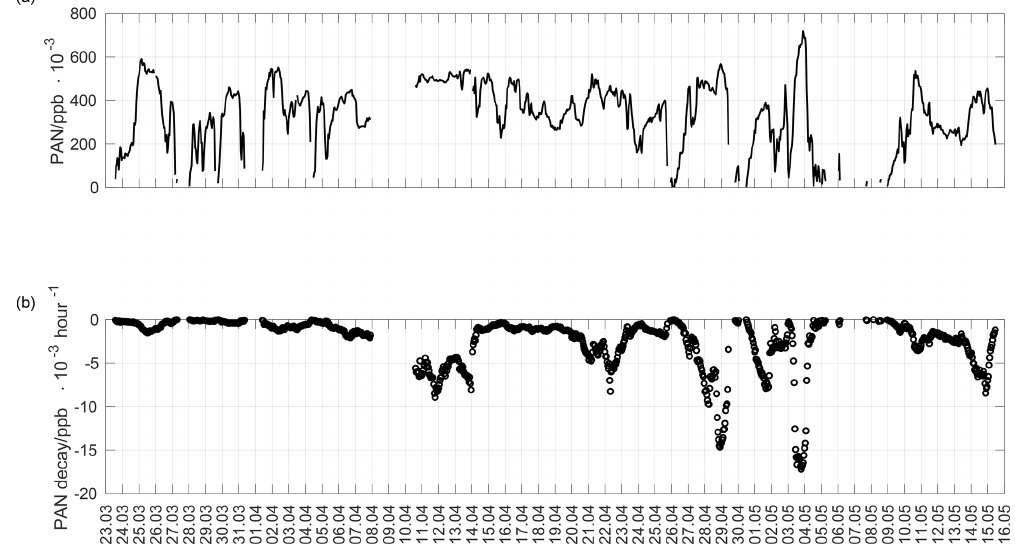
Figure A2. (a) PAN concentration calculated using the linear relationship between PAN and O 3 concentration suggested by Beine and Krognes (2000). (b) PAN decomposition rate calculated using Eqs. (1) and (2) from Beine and Krognes (2000).